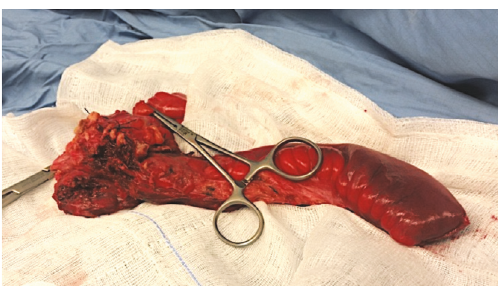
Figure 3: Surgical specimen reveals multiple punched out ulcera- tions along a diffusely thickened terminal